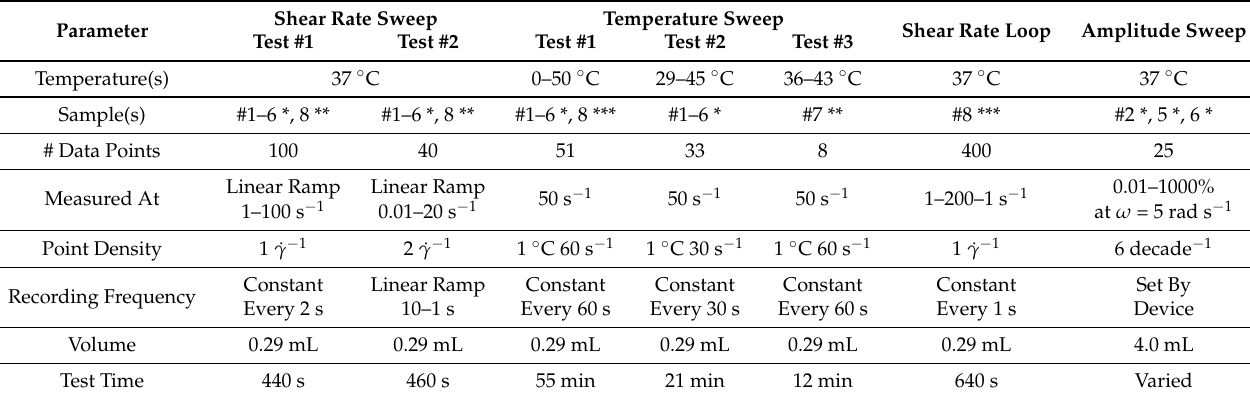
Table 3. Viscosity Testing